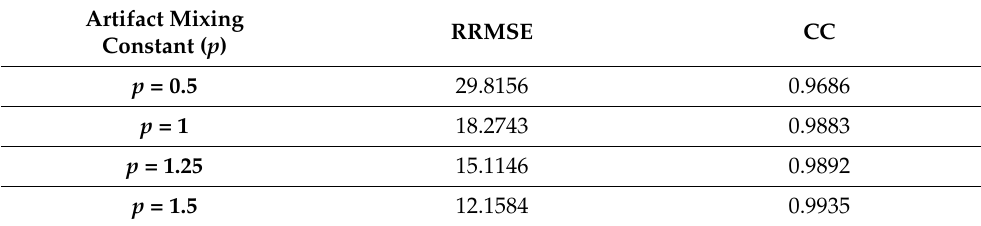
Table 1. Mean values of RRMSE and CC with different p